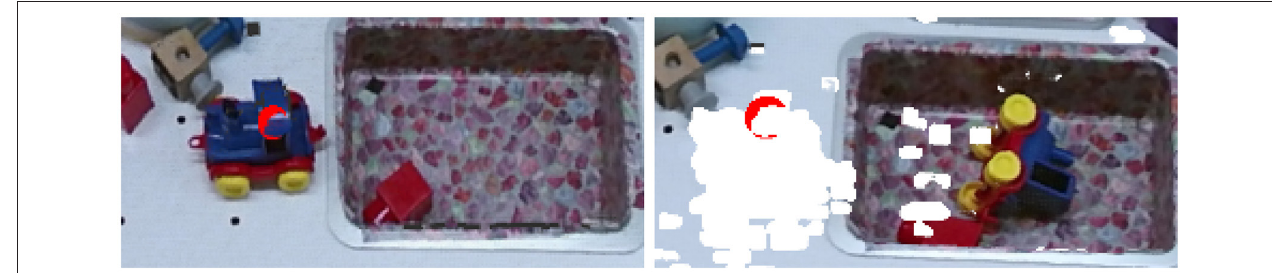
FIGURE 5 | Visualization of the change detector. The right picture represents a part of a scene before a push and the left picture after a push. The red dot on both pictures represents the target of the push primitive which is here the upper part of the blue toy. This target corresponds to the center of a supervoxel. The white areas represent the parts detected as different between both images.